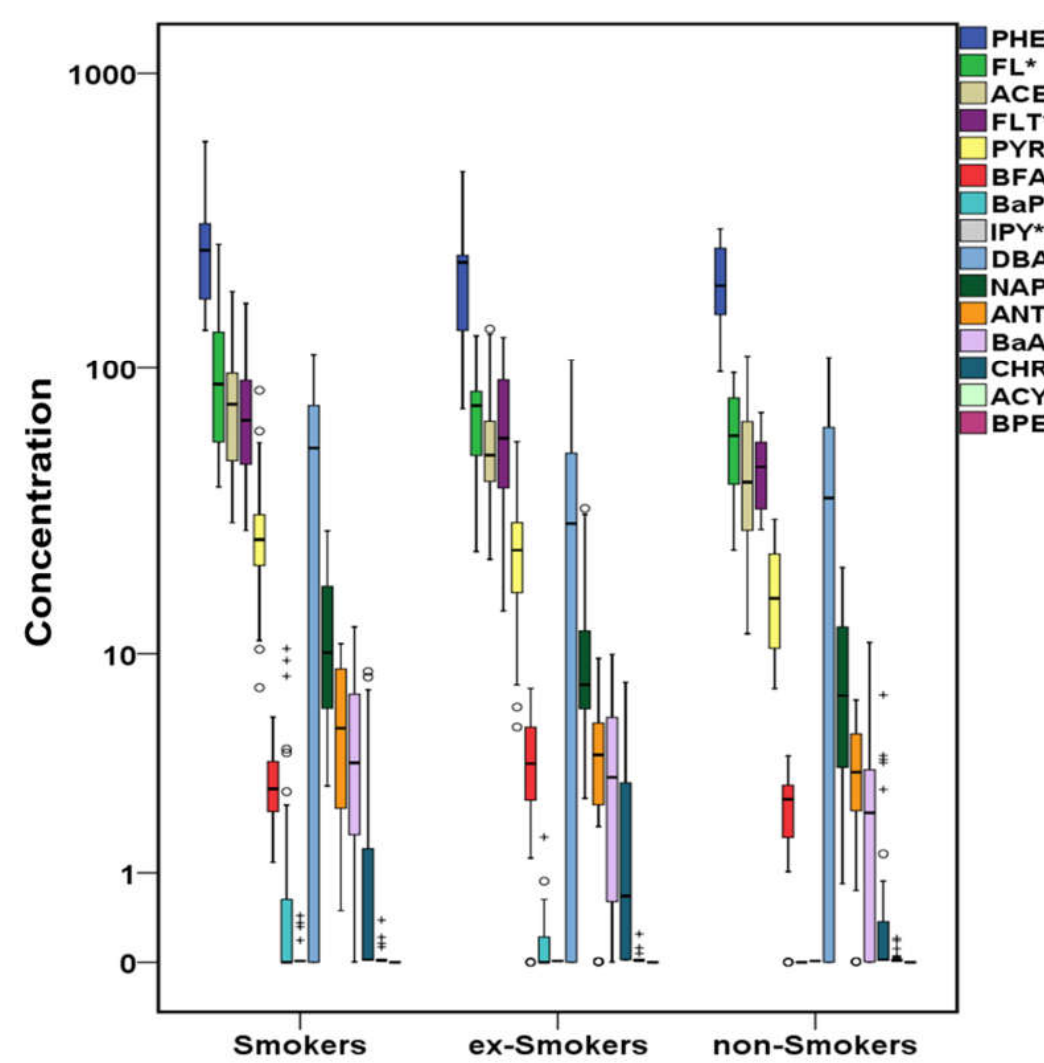
Figure 6. Variation of PAHs (μg L −1 ) in cases’ serum regarding the smoking habit ( + outliers, o values above 3rd quartile, and * p -value <0.05) in logarithmic scale (PHE:phenanthrene, FL:fluorene, ACE:acenaphthene, FLT:fluoranthene, PYR:py-